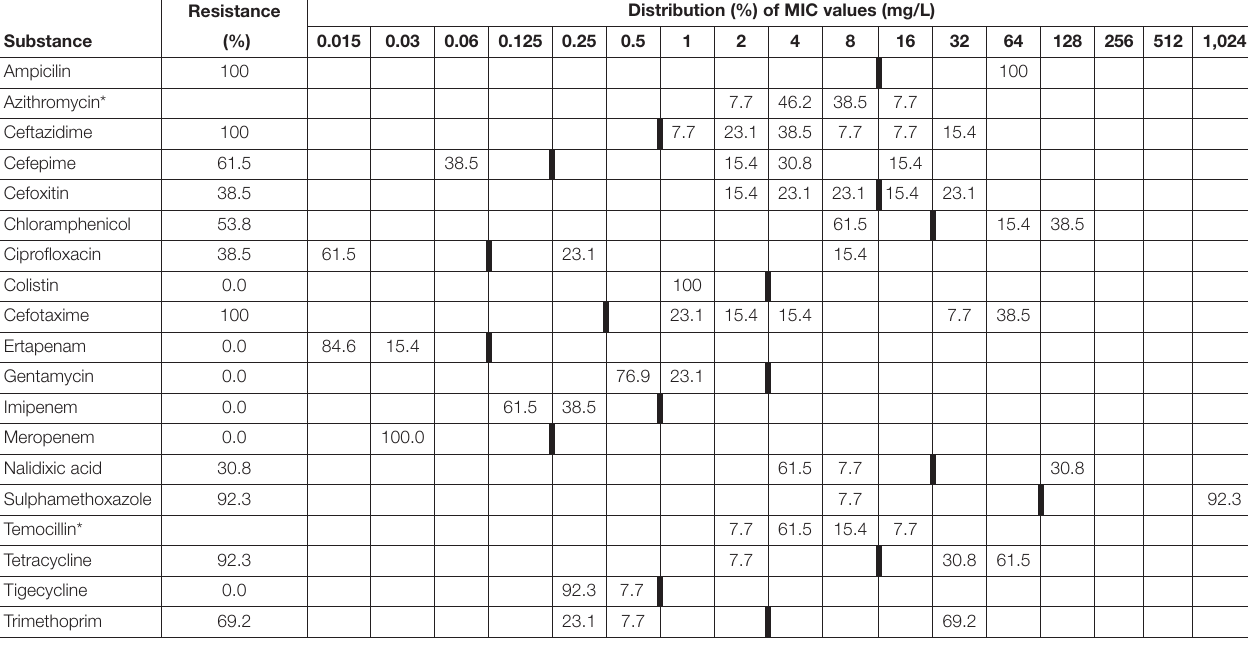
TABLE 2 | Minimum inhibitory concentrations (MICs) and antimicrobial resistance in ESBL Escherichia coli isolated from faecal samples ( n = 16) from badgers ( Meles meles ) in Northern Ireland in 2018–2019.